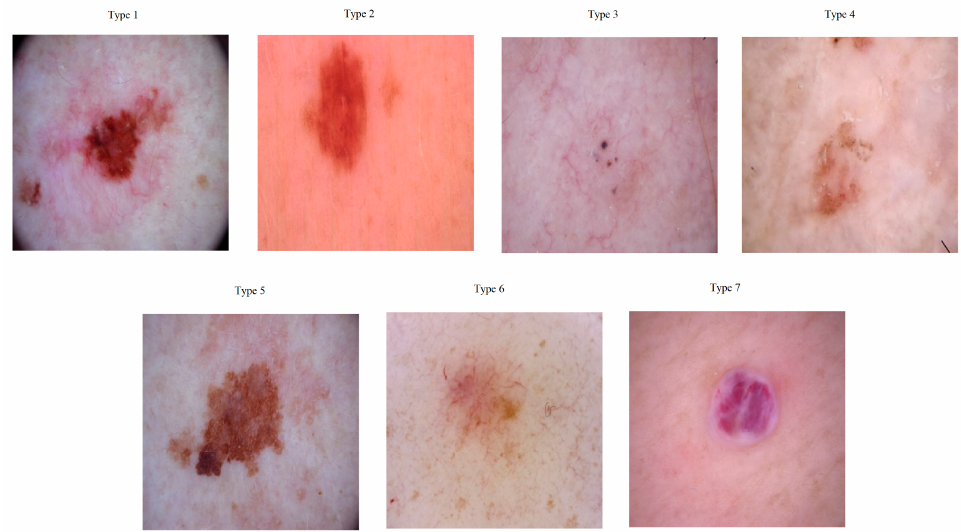
Figure 4. Sample skin lesions in the HAM10000 dataset. Type 1: MEL; Type 2: NV; Type 3: BCC; Type 4: AKIEC; Type 5: BKL; Type 6: DF; Type 7: VASC.